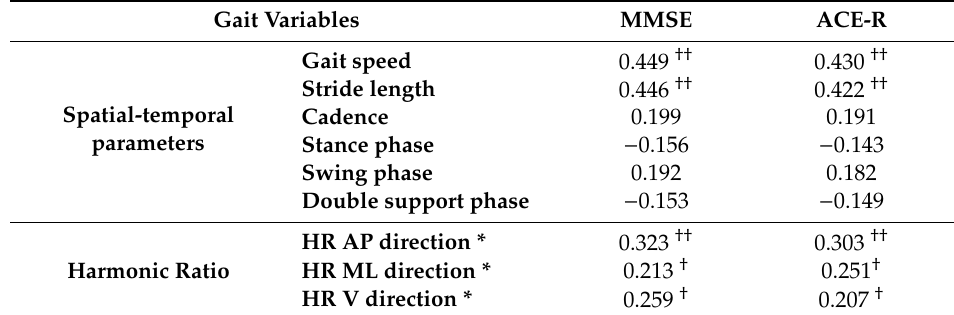
Table 3. Spearman’s coe ffi cients for correlations between spatial-temporal and smoothness of gait parameters and scores obtained from the neuropsychological